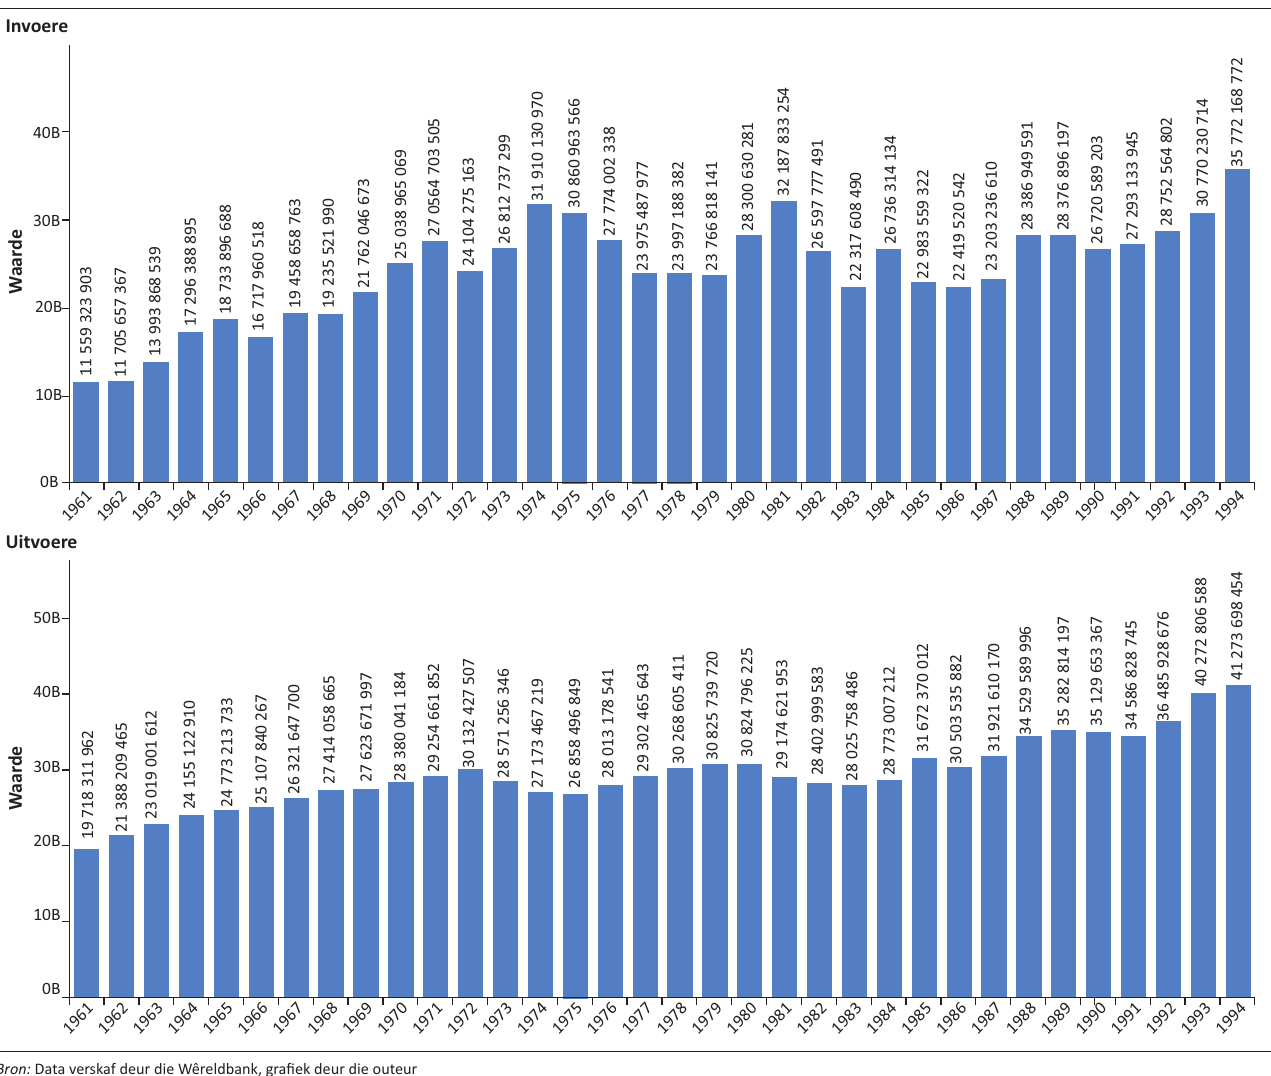
FIGUUR 4: Suid-Afrika se in- en uitvoere vanaf 1961 tot 1994 in konstante 2005